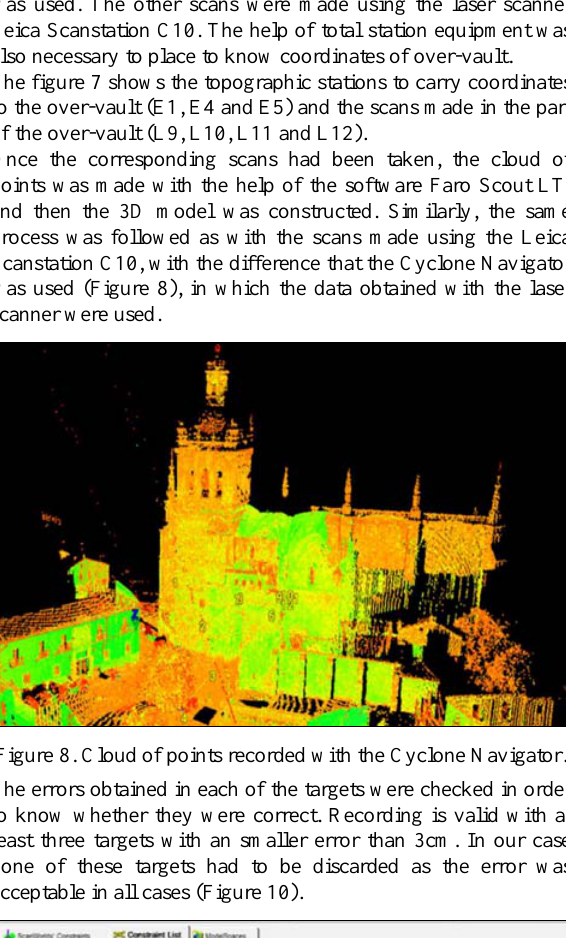
Figure 10. Mean error of geo-referencing.